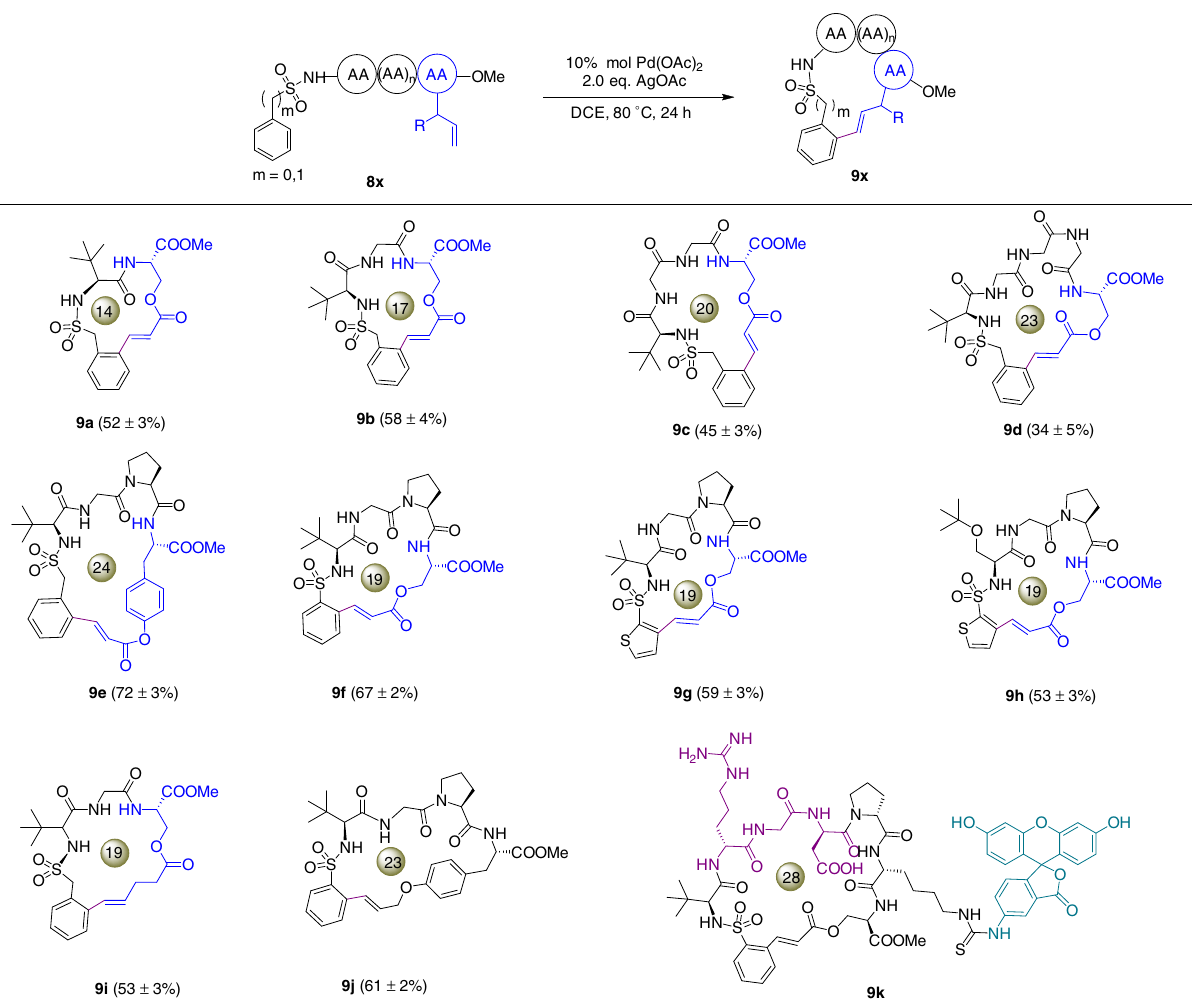
Fig. 5 Macrocyclization of peptidosulfonamides by self-guided C – H ole fi nation. a Synthesis of peptidosulfonamide macrocycles. b FITC-labeled cyclic RGD peptide 9k and its integrin binding assays analyzed by confocal microscopy. All peptides were used at 2 µ M concentration for the cell binding studies. The RGD motif is in red and the fl uorescein motif is in green. The isolate yields were determined by three repeats of the